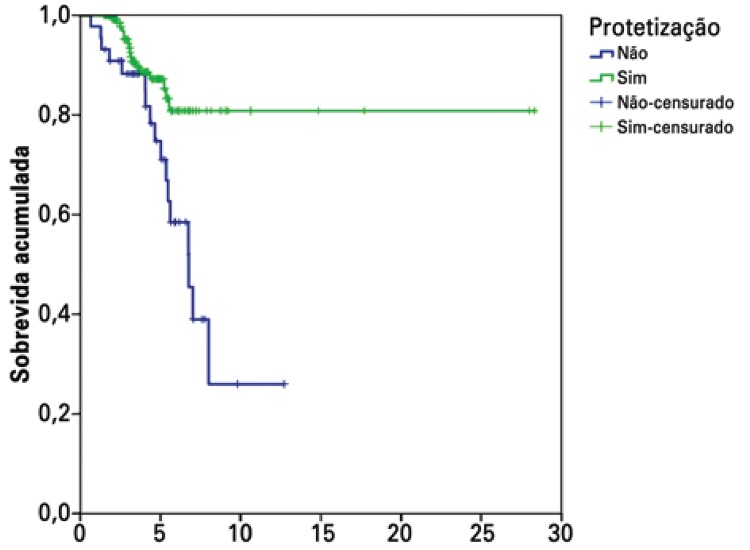
Gráfico de sobrevida de Kaplan-Meier